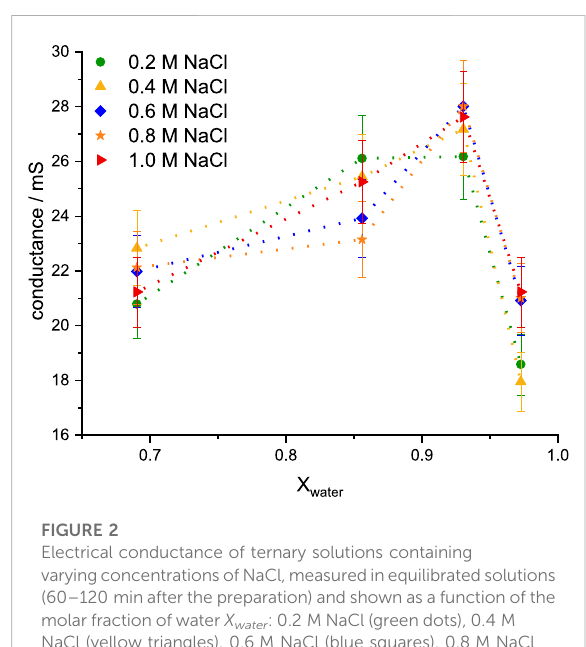
FIGURE 2 Electrical conductance of ternary solutions containing varyingconcentrationsofNaCl,measuredinequilibratedsolutions (60 – 120 min after the preparation) and shown as a function of the molar fraction of water X water : 0.2 M NaCl (green dots), 0.4